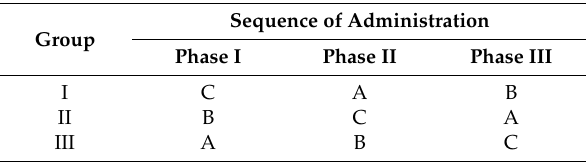
Table 2. Sequence of administration of griseofulvin-loaded liposomes prepared using various